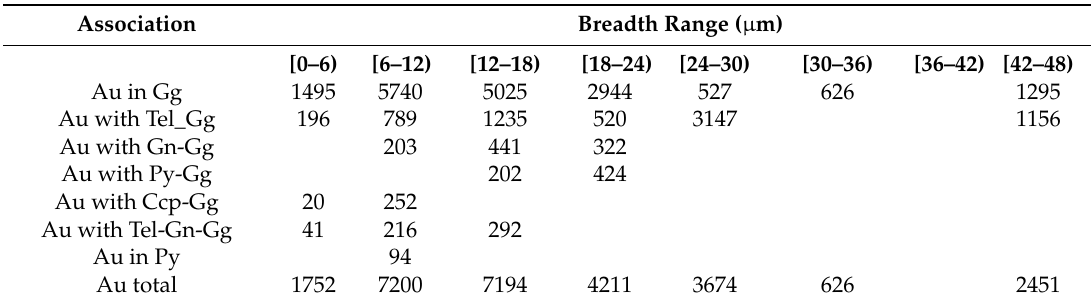
Table 4. Areas of gold grains ( µ m 2 ) according to their mineral association and gold size passing range (breadth in µ m). Samples: MB-21 and MB-21b. Class interval: 6 µ